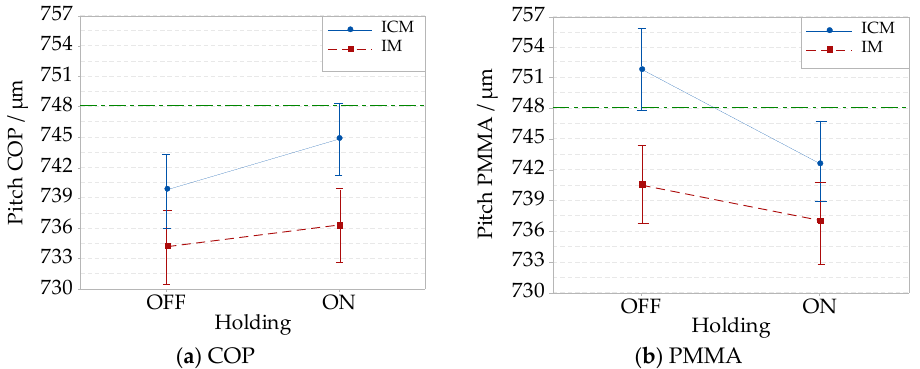
Figure 7. Interaction plots showing the replication of the absolute dimensions of Fresnel lens’ grooves with a nominal width of 748.1 µm. The measurement uncertainty is added to the results obtained for IM without holding pressure, IM with holding pressure, ICM without holding pressure, and ICM with holding pressure: ( a ) COP material; ( b ) PMMA material.